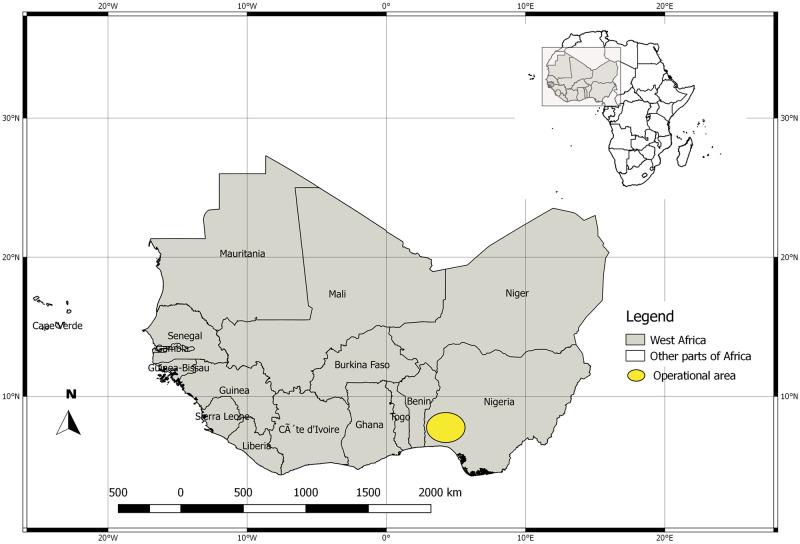
Map showing West African countries and the operational area in southwest Nigeria.